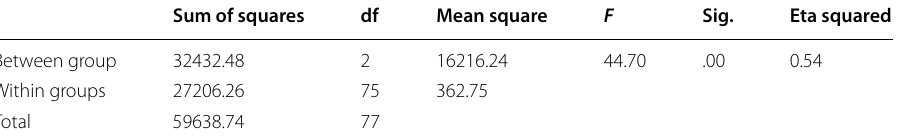
Table 10 Findings of one-way ANOVA: the participants’ posttests of FLCA scores Sum of squares df Mean square F Sig. Eta squared Between group 32432.48